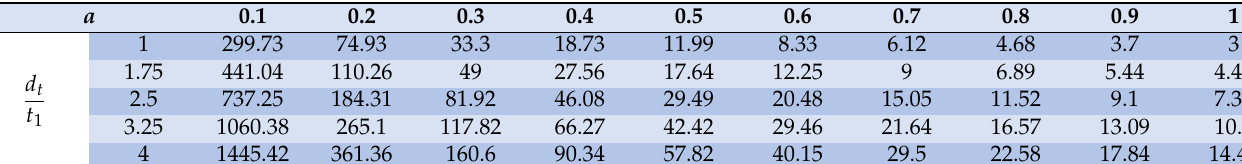
Figure 11. Buckling affected by the thickness ratio of the core layer.